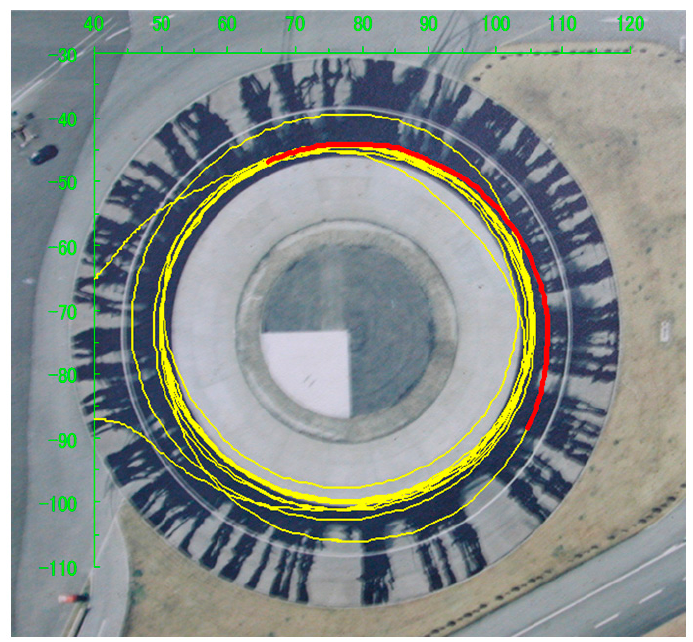
Figure 5. The aerial photo of the skid pad superimposed by the GPS trajectory of the vehicle’s center of gravity.